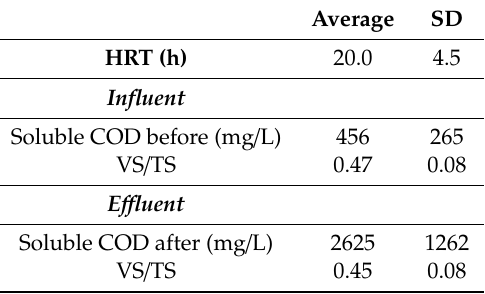
Table 1. Average values and standard deviation (SD) of thermal pretreatment